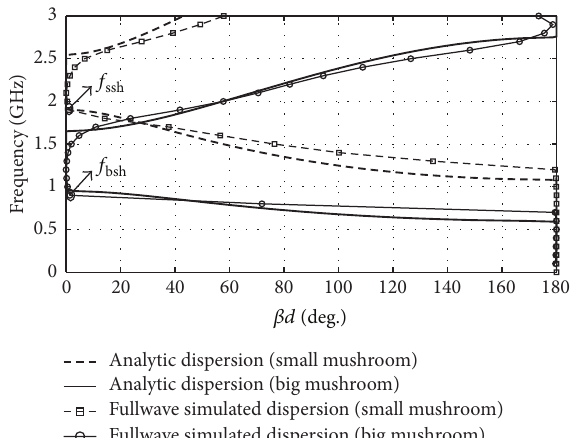
Figure 4: Analytic and fullwave simulated dispersion diagram of both modified mushroom